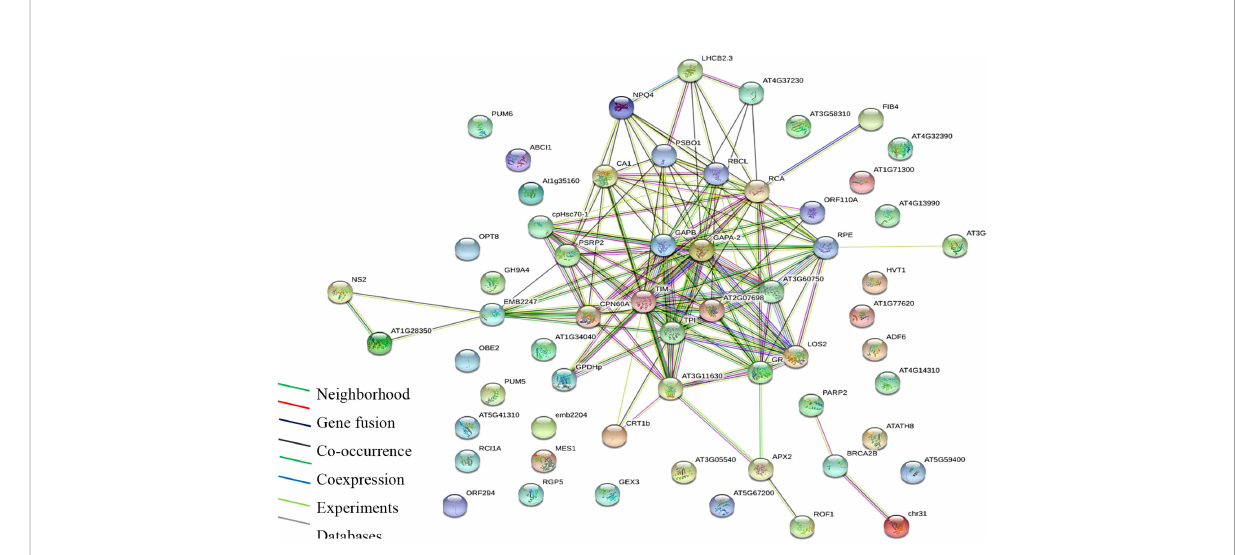
FIGURE 3 Protein interaction network (PPI) of identi fi ed proteins. Analysis performed using STRING via the https://string-db.org/cgi/network. PPI enrichment is signi fi cant (P ≤